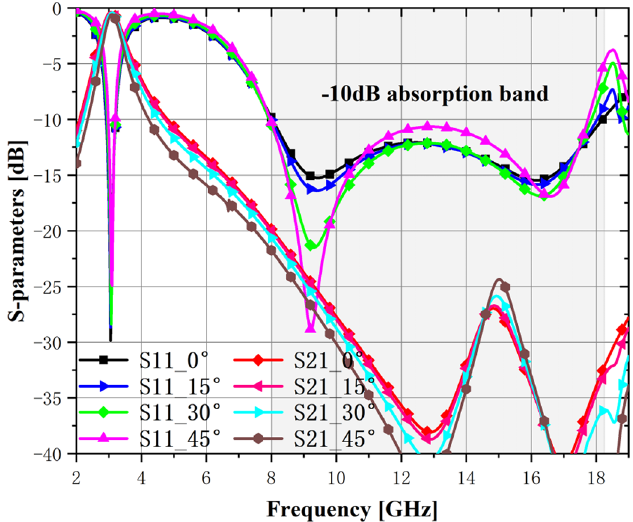
Fig. 6. S-parameter of the designed FSR for different incident angles under dual polarization